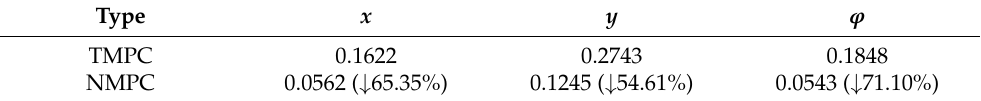
Table 4. The RMSE comparisons of the tracking errors of x , y , and ϕ under the TCT.